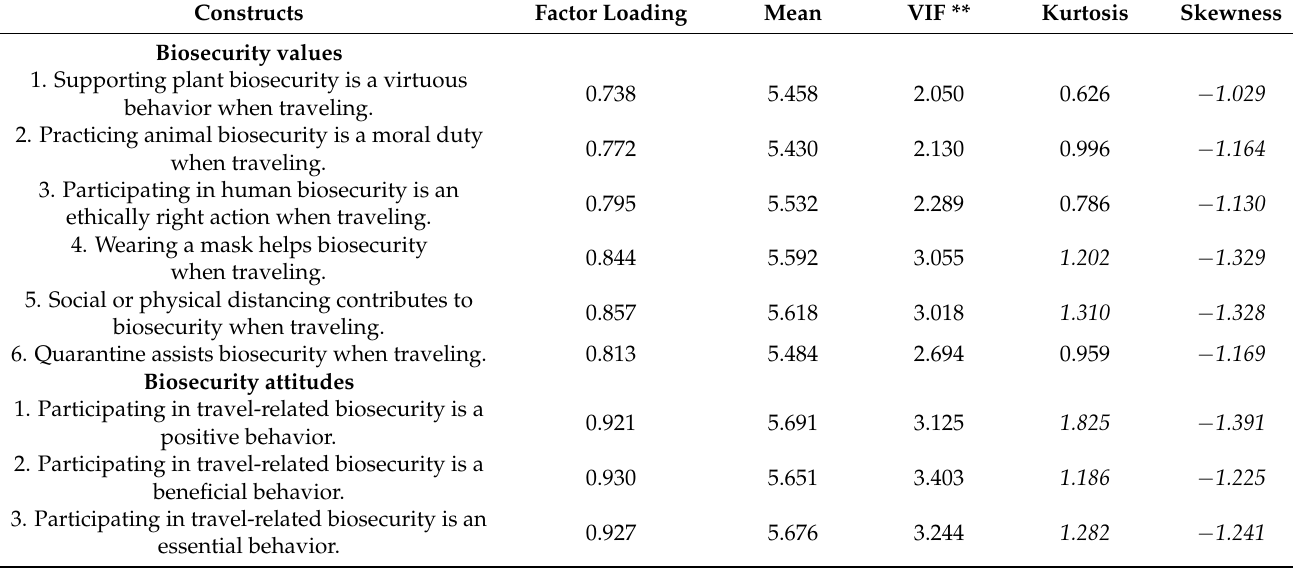
Table 3. Confirmatory factor analysis (CFA) and descriptive